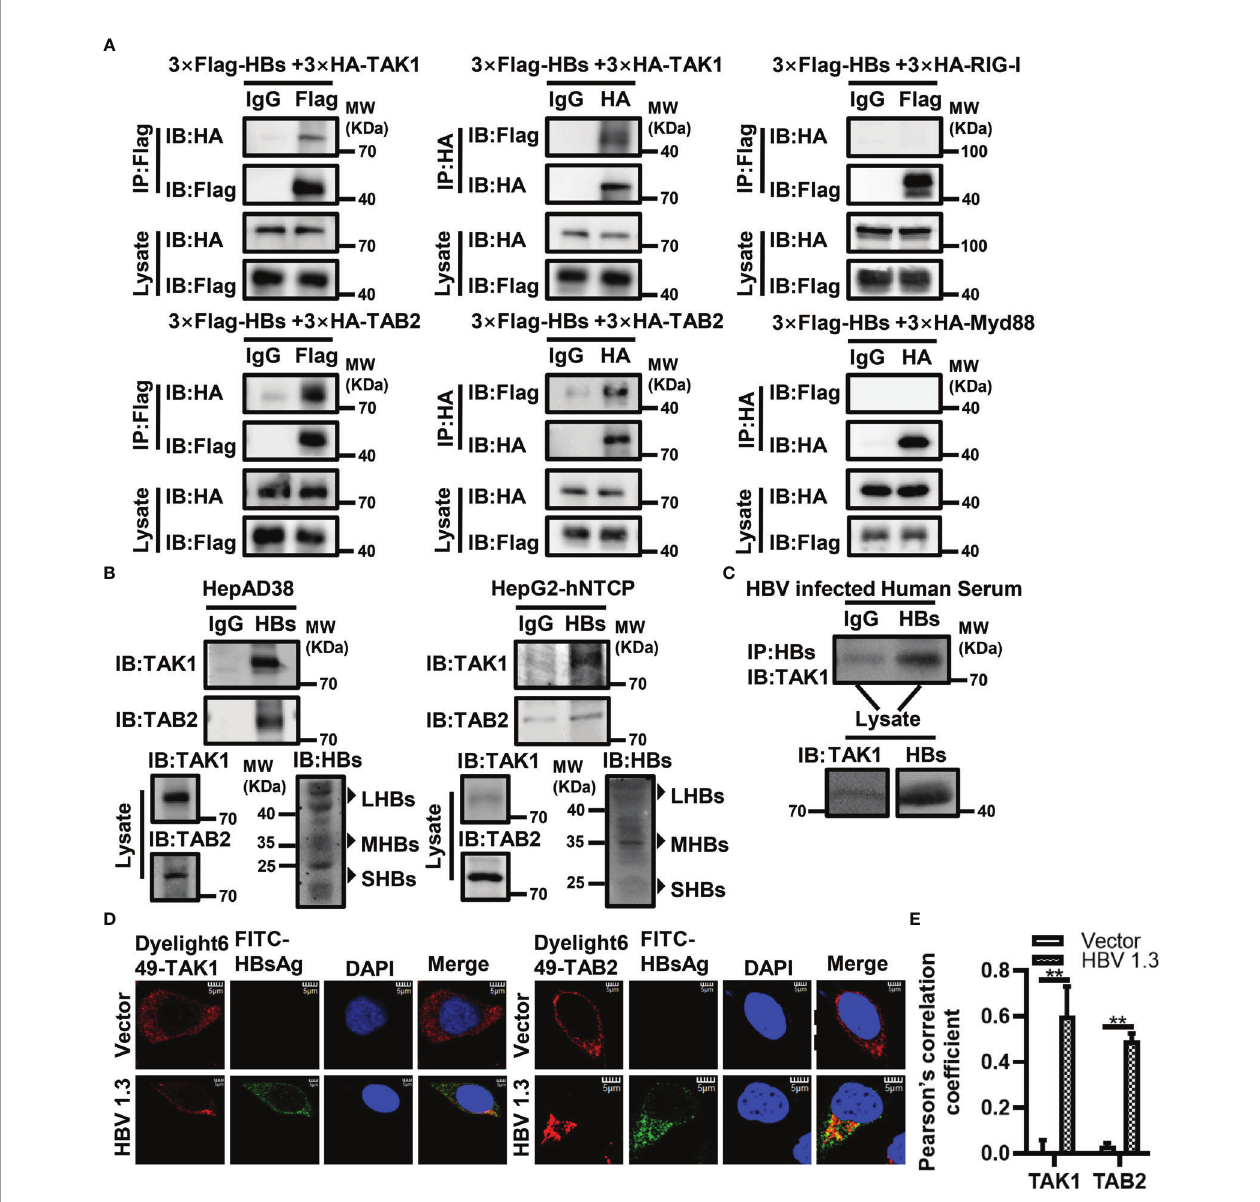
FIGURE 2 | HBsAg interacts with TAK1 and TAB2 speci fi cally in vitro and in vivo . (A) 3×Flag-HBs or vector plasmids were co-transfected into human embryonic kidney (HEK293T) cells with 3×HA-TAK1/TAB2/RIG-I/Myd88, at 48 h post transfection, cells were harvested for Co-IP assays. (B) HepAD38 cells were seeded in 10-cm wells, and then harvested for Co-IP assays at 48 h later. HepG2-hNTCP were seeded in 10-cm wells with primary hepatocytes maintenance medium (PMM) for 6 h, and then infected with 1000 multiplicity of genome equivalents of HBV in PMM with 4% PEG 8000 at 37°C for approximately 16 h. After the virus- containing medium were removed, cells were washed with PBS three times to remove residual viral particles and cultured in fresh PMM medium. The medium was refreshed every other day. Cells were harvested for Co-IP assays on 7 days after infection. We divided the cell lysate of HepAD38 cells or HBV infected HepG2- hNTCP cells into three. One of which was immunoprecipitated with IgG, one was with anti-HBsAg antibody, and the other was prepared as lysate for western blot. Proteins were immunoblotted with indicated antibody. (C) The serum of HBV infected patients was diluted 20 times for Co-IP assays. We divided the diluted serum into three aliquots. One of which was immunoprecipitated using IgG, one was incubated with anti-HBsAg antibody, and the other was used for western blot. Proteins were immunoblotted with indicated antibodies. We found that HBsAg interacted speci fi cally with TAK1 in vivo . (D) HepG2 cells were plated on collagen incubated in 14-mm confocal dishes, and then HBV1.3 expression plasmids or control vector were transfected into HepG2 cells for 24 h to conduct confocal microscopy assays. HBsAg were stained with fl uorescein (FITC)-Af fi niPure goat anti-horse IgG (H+L). TAK1 and TAB2 were stained with Dylight 649 goat anti-rabbit IgG. The nuclei were stained with 4 ’ ,6-diamidino-2-phenylindole (DAPI). The cells were imaged using a fl uorescence microscope (Leica, Germany) with 100× objective lens. Scale bar = 5 m m. (E) We analyze the level of colocalization between HBsAg with TAK1/TAB2 by using Image J and GrapPad Prism 8. The graphs show the means ± SD, n = 3 (**P <